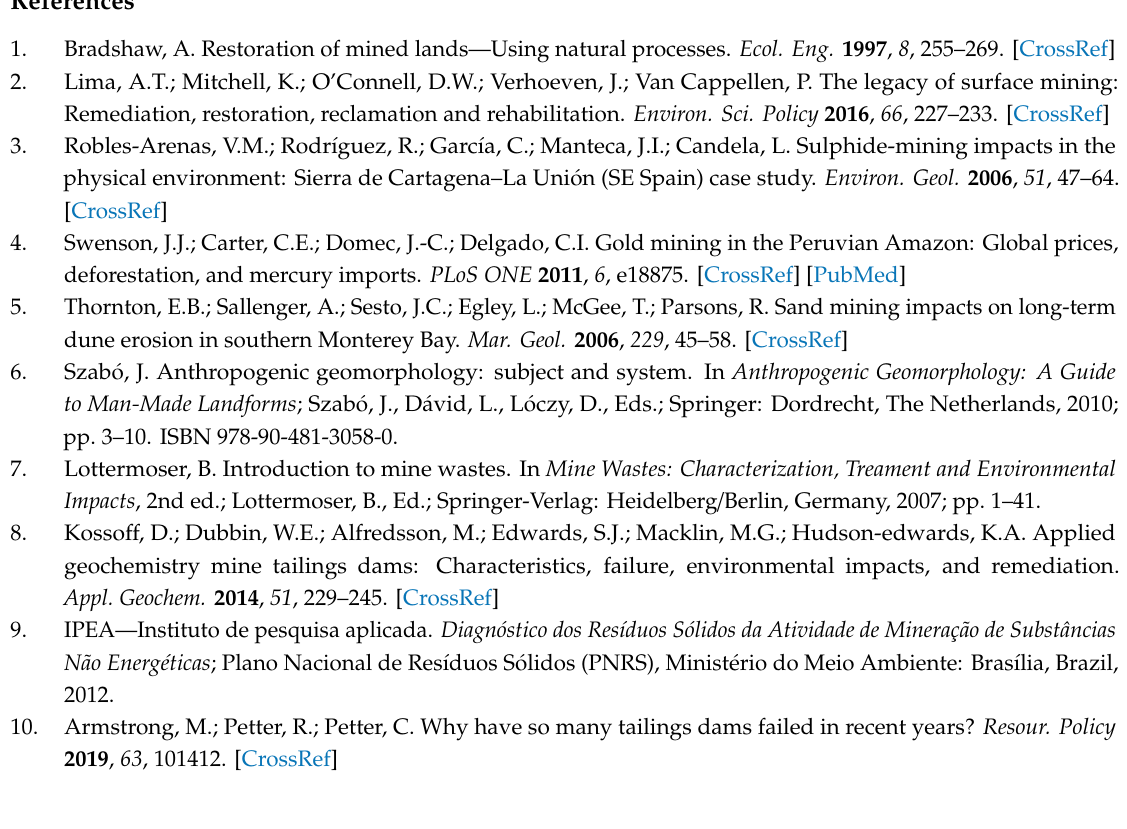
Table S1: Limestone mining area of the State of S ã o Paulo; Table S2: Limestone mining titles of the whole Brazilian territory, divided into federative